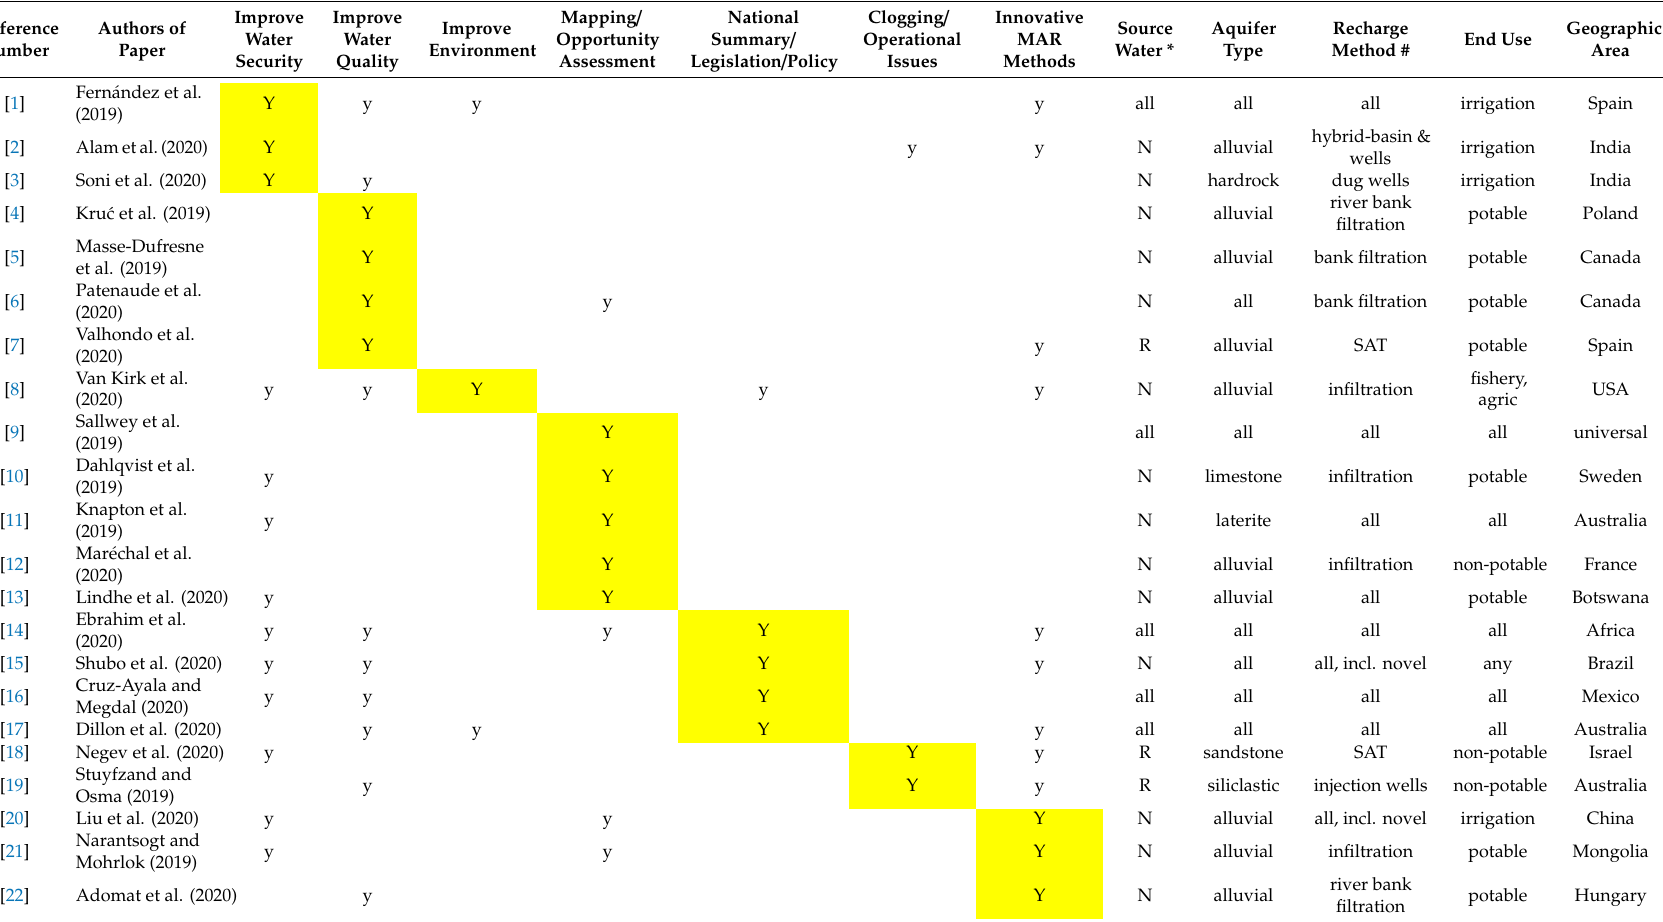
Table 1. Directory to the matters addressed and the characteristics of managed aquifer recharge (MAR) sites for each paper; Highlighting shows the introductory paper section